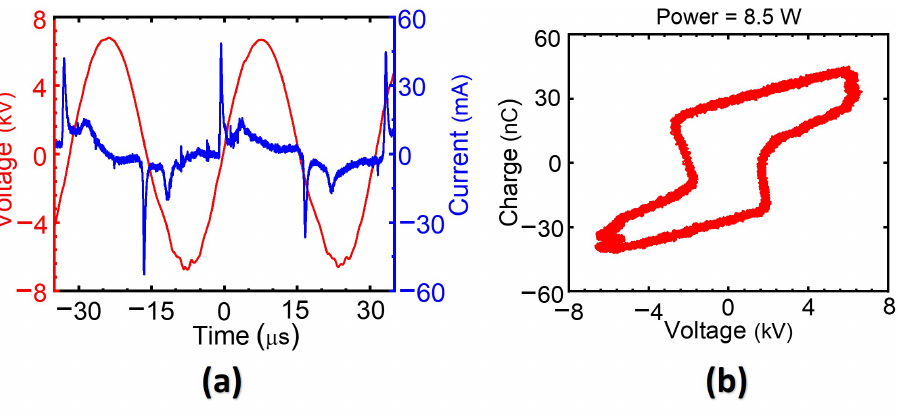
Figure 2. ( a ) Typical current and voltage waveforms of the plasma discharge for the J2 jet, and ( b ) corresponding Lissajous